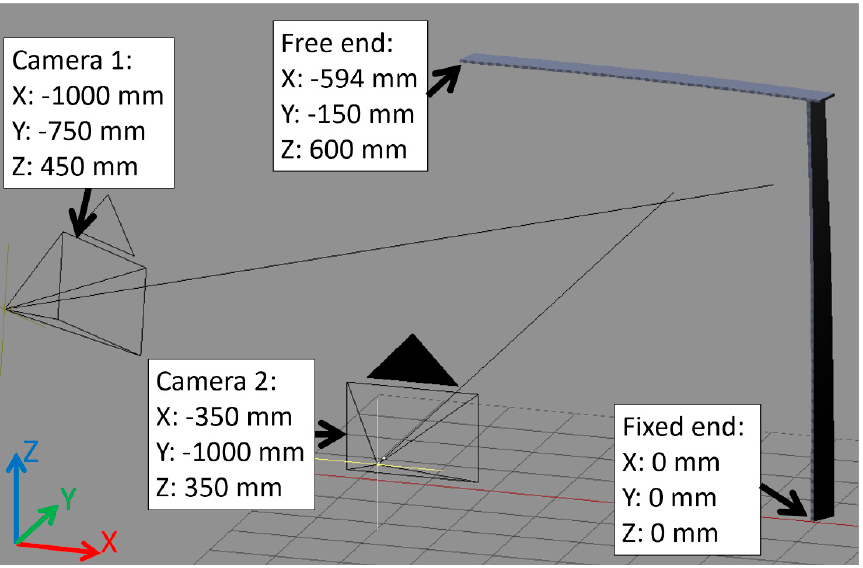
Figure 8. Spatial arrangement of cameras and the tower crane sample in multicamera simulation.